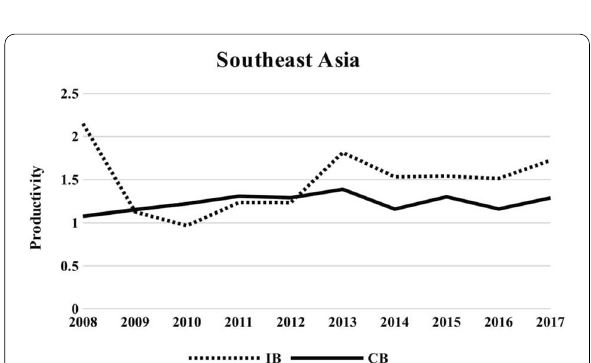
Fig. 3 Levels of productivity by years in Southeast Asia